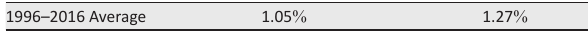
TABLE 1: Crop yield growth rate per hectare and population growth rate. Average Crop yield growth Population growth rate per hectare